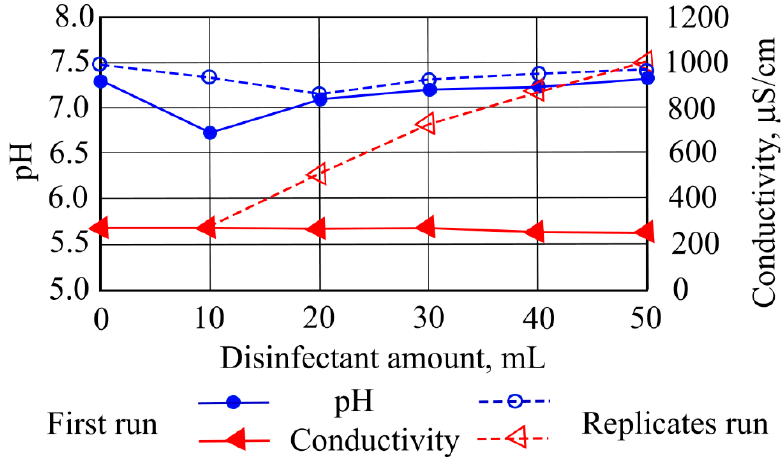
Figure 5. The impact of disinfectants on pH and conductivity.